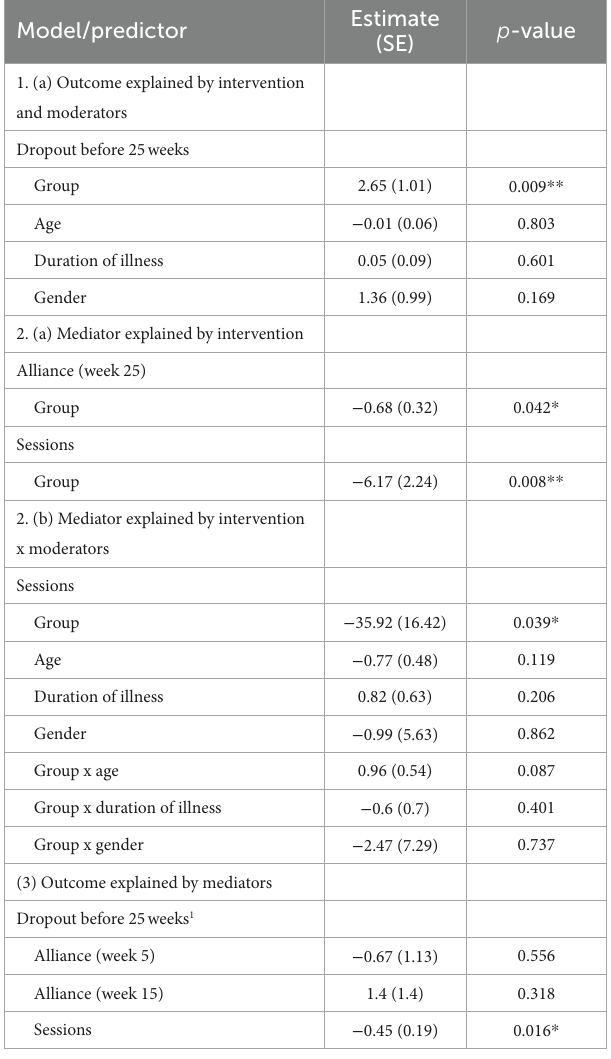
TABLE 4 Linear and generalized linear models (selection). Model/predictor